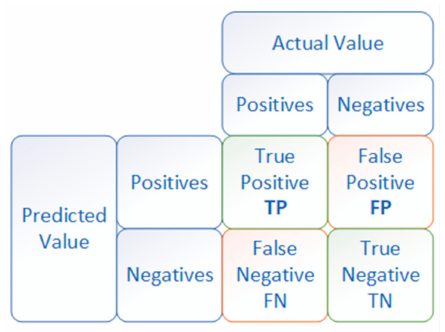
Figure 10. Confusion